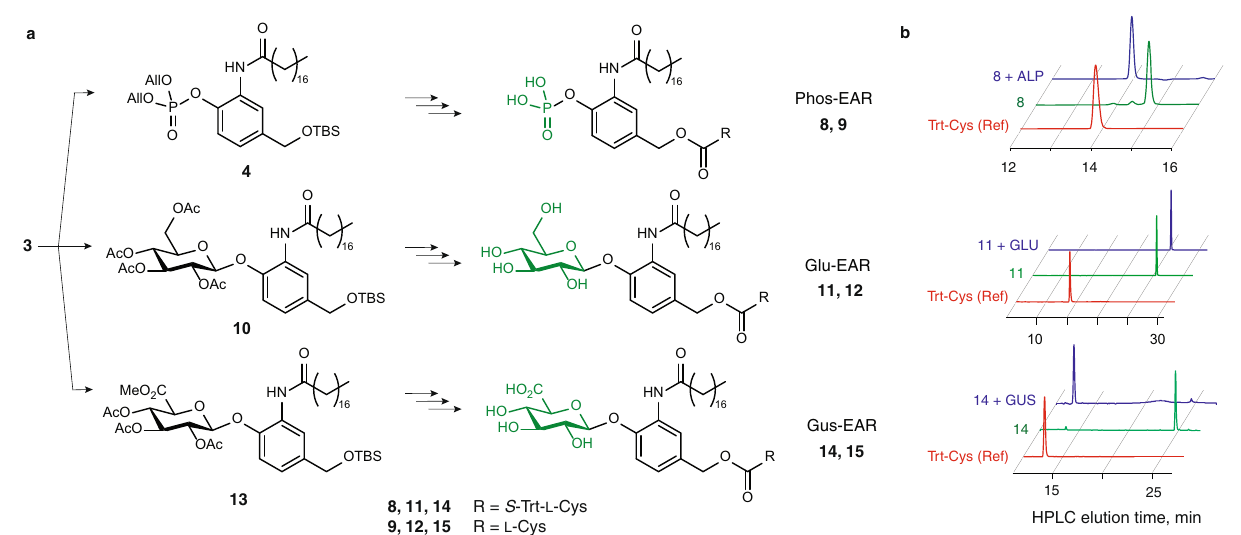
Fig. 3 | Diversityofthe synthetic receptor molecules. a Schematic illustration of thesynthesisofthreedifferentreceptormoleculesforALP,GLU,andGUS-mediated activation: Phos-EAR( 9 ),Glu-EAR ( 12 ),and Gus-EAR ( 15 ), respectively. b HPLCdata